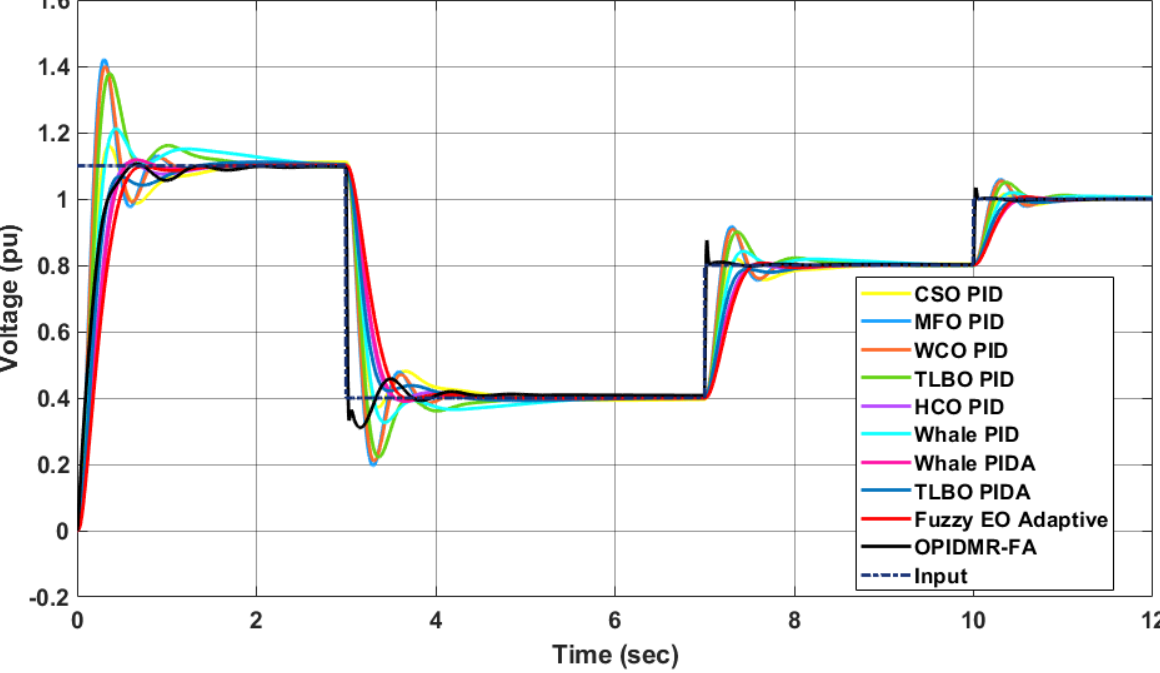
Figure 13. AVR system response under dynamic input voltage.